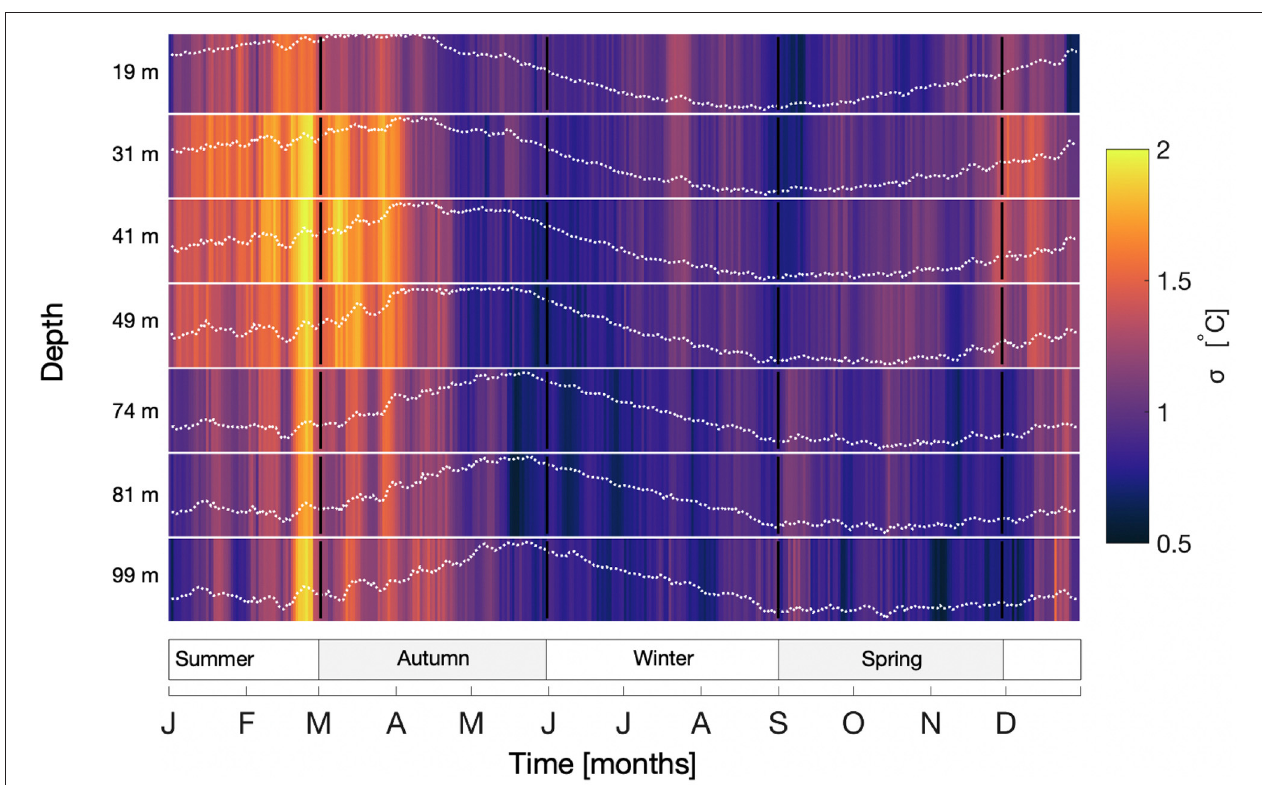
FIGURE 10 | The temperature climatology standard deviations ( σ ) are shown as constant bars for each day of the year and climatology depth. Note the varying intervals between climatology depths. The normalized mean temperatures (see Figure 9A for values) are superimposed over the standard deviations as white dashed lines for each climatology depth. The seasons are labeled below the plot area along with corresponding black vertical lines signifying a change of season, shown for each climatology